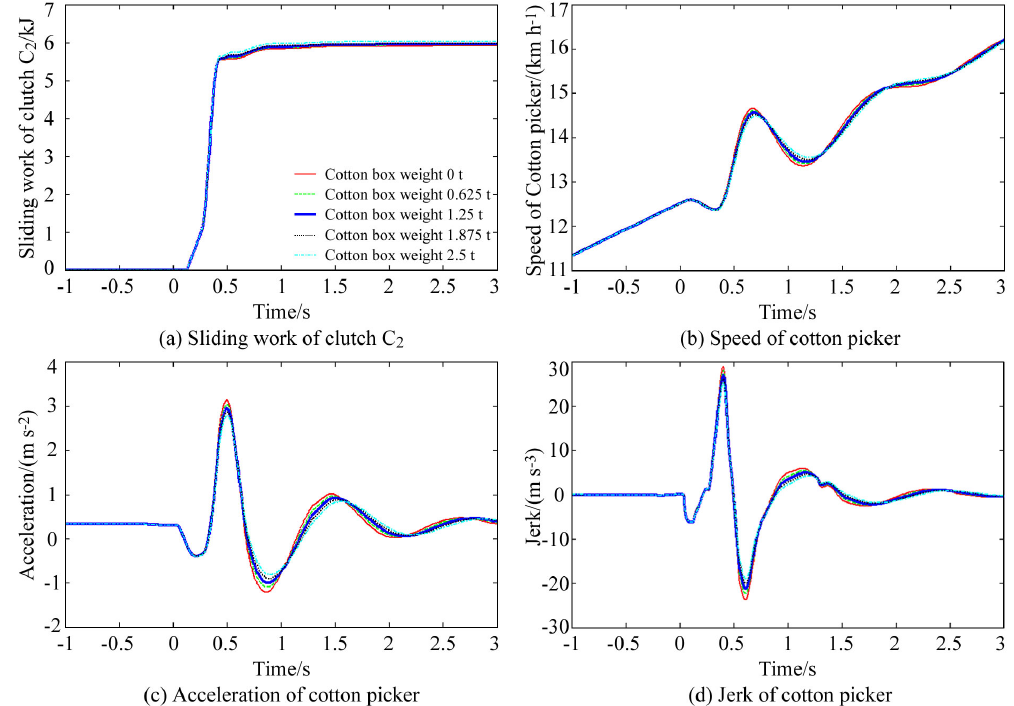
Figure 11. Influence of cotton box weight on the shift quality of the cotton